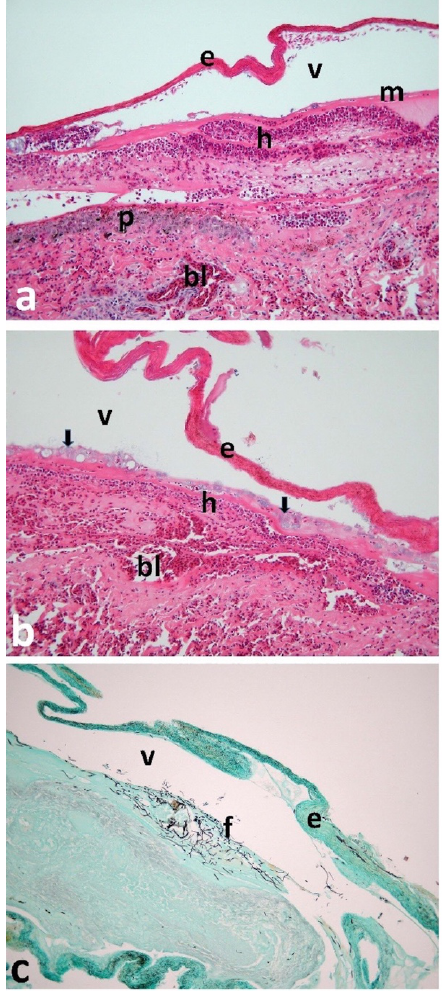
Figure 2. Light microscope images (×100 magnification using a Leica Pathology microscope fitted with a Nikon Coolpix camera) of sections of the foot web skin. Sections ( a , b ) were stained with haematoxylin and eosin (H&E) for general histology, while section ( c ) was stained with Grocott’s silver-impregnation technique to display fungal elements. ( a ) The keratinised layer of the epidermis (e) was elevated from the basal lamina (m) by a fluid-filled vacuole (v), forming a blister. In the superficial dermis, many heterophils (h) were massed together, representing an acute inflammatory reaction. Pigment-containing cells (p) were also present in the dermis, and numerous small dermal blood capillaries (bl) were congested with erythrocytes. ( b ) Numerous blue-grey-stained bacterial colonies (arrows) were present at the base of the epidermis and in the superficial dermis. The kerat- inised layer of the epidermis (e) was elevated by the blister fluid (v), and congested blood vessels